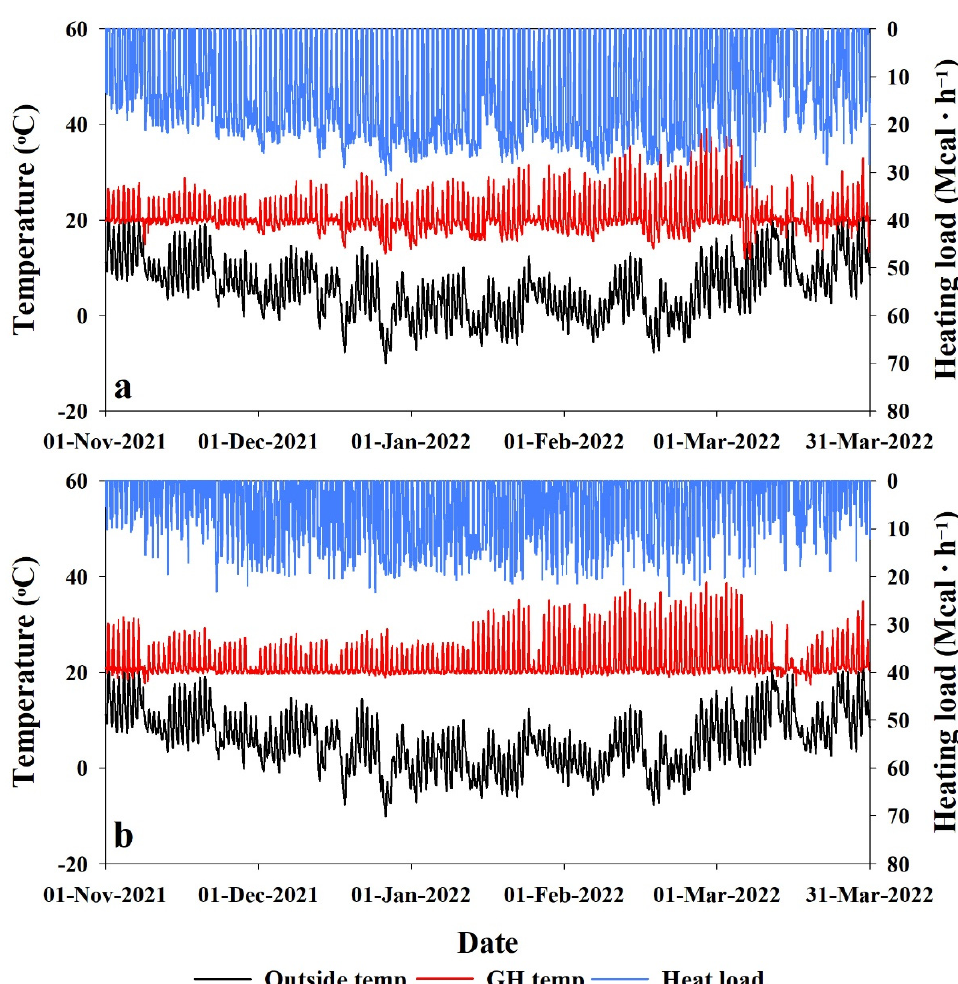
Figure 9. Analysis of greenhouse internal environment during winter: ( a ) GH 1 and ( b ) GH 2.